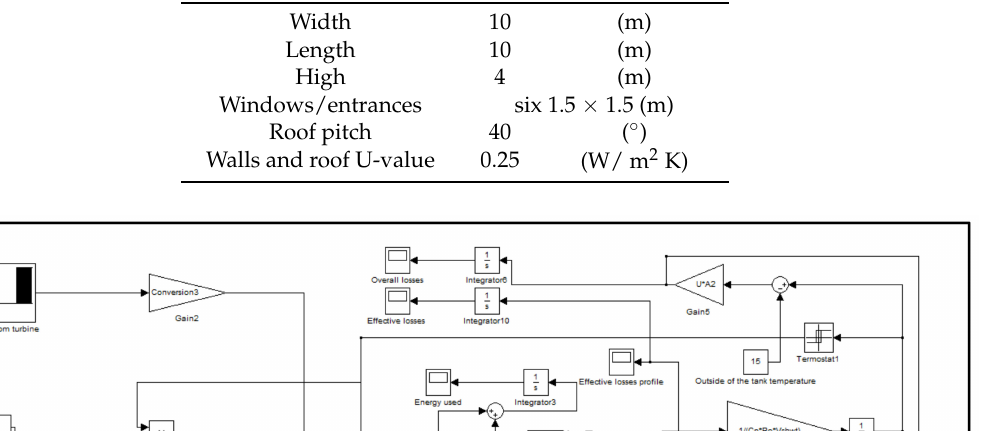
Table 4. Specifications of the simplified house considered.